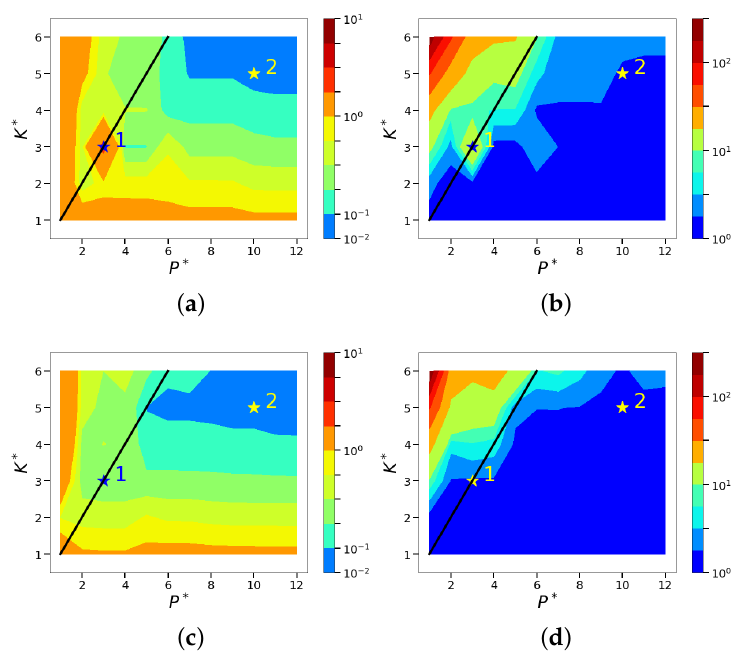
Figure 7. Isocontours of the normalized mean squared POD-based sparse reconstruction errors ( l 2 norms) using different random seeds (101 and 102) for sensor placements. Left: normalized absolute error metric, (cid:101) 1 . Right: normalized relative error metric, (cid:101) 2 . ( a ) (cid:101) 1 (seed = 101); ( b ) (cid:101) 2 (seed = 101); ( c ) (cid:101) 1 (seed = 102); and ( d ) (cid:101) 2 (seed = 102).